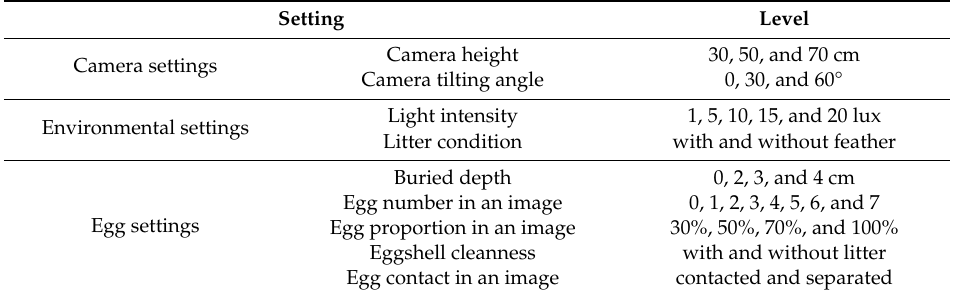
Table 1. Settings for evaluating the optimal convolutional neural network (CNN) floor-egg